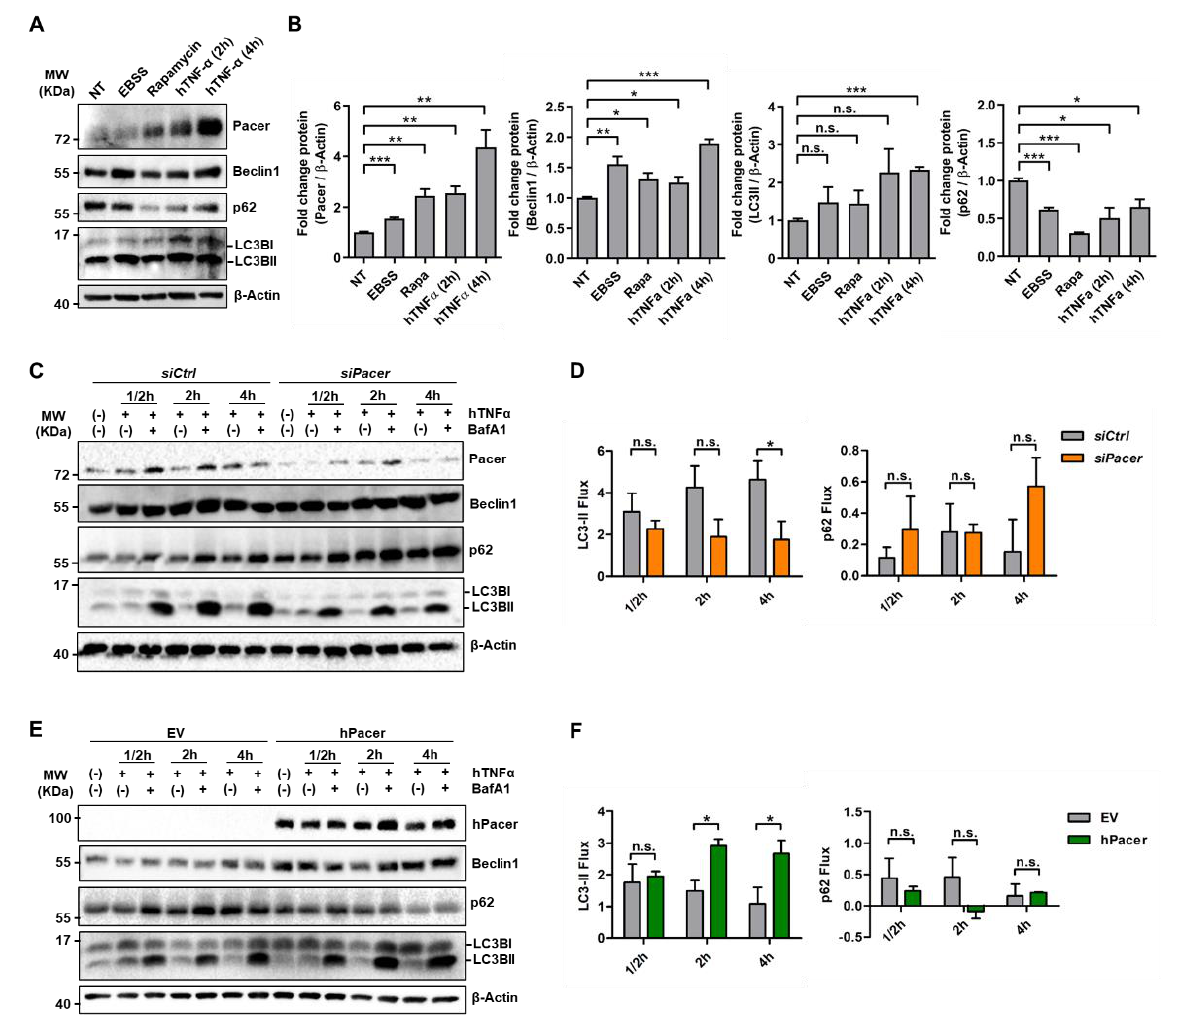
Figure 1. Pacer gain and loss of f unction affects autophagy flux in MSC treated with hTNFα. ( A ) MSC were treated with EBSS (4 h), Rapamycin (4 h) (200 nM) and hTNFα (10 μg/mL for 2 h or 4 h). Non-treated control cells are designated as NT. Western blot analysis showing the levels of mouse Pacer, Beclin1, SQSTM1/p62 and LC3B. β -Actin was used as a loading control. A